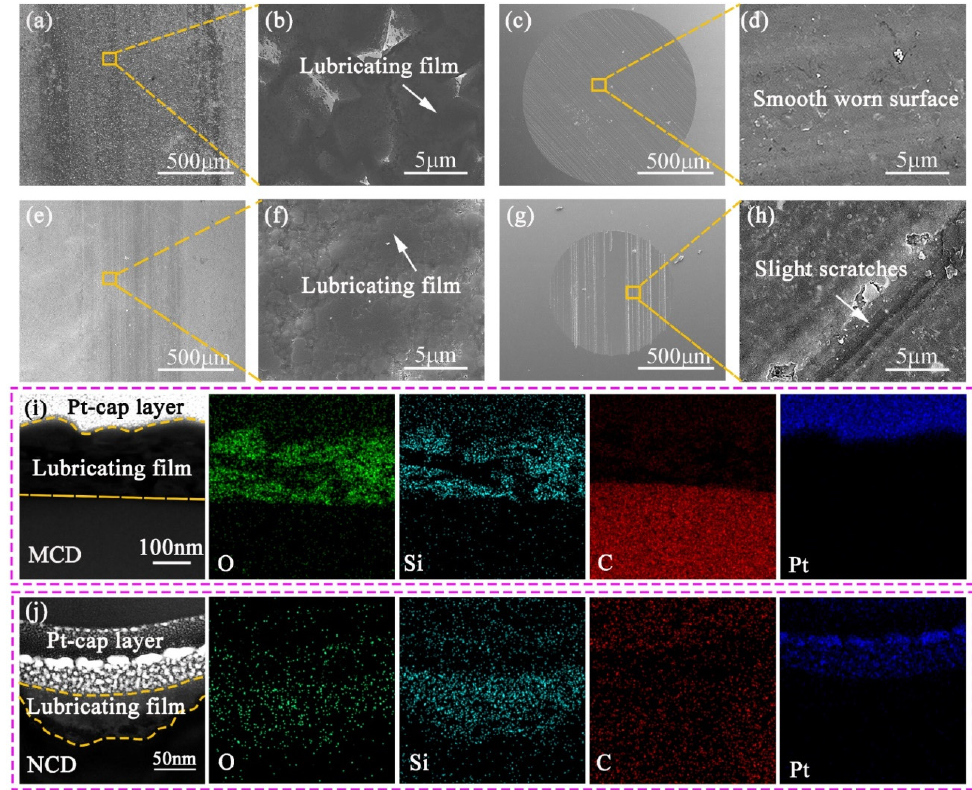
Figure 7. ( a , b ) The worn scars of MCD coatings sliding against SiC balls in the seawater environment; ( c , d ) The worn scars of SiC sliding against MCD coatings in the seawater environment; ( e , f ) The worn scars of NCD coatings sliding against SiC balls in the seawater environment; ( g , h ) The worn scars of SiC sliding against NCD coatings in the seawater environment; ( i ) The EDS mapping of the transfer film formed on the frictional zones of MCD diamond coatings; ( j ) The EDS mapping of the transfer film formed on the frictional zones of NCD diamond